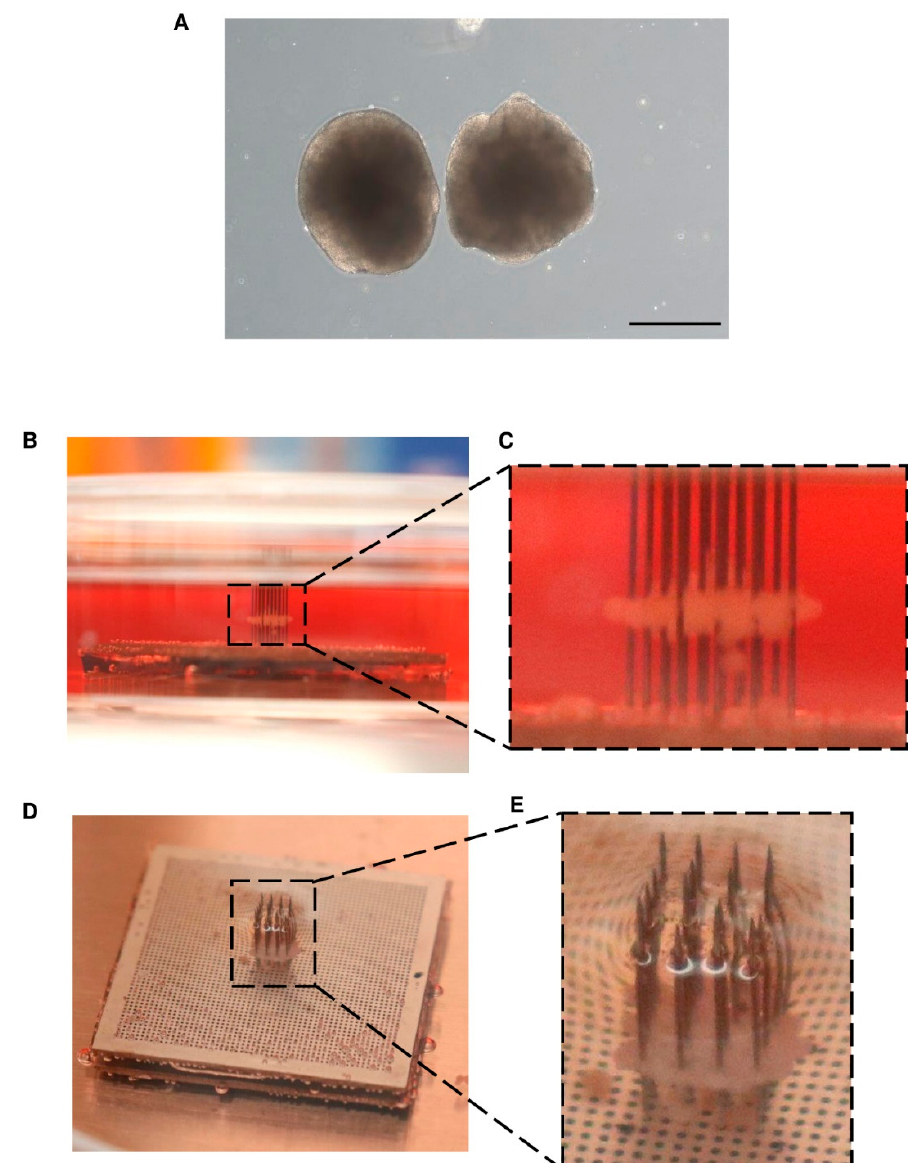
Figure 6. Proof-of-concept testing with human induced pluripotent stem cells (hiPSC) spheroids. hiPSC spheroids were cultured using a rotating culture flask method. ( A ) The spheroids were grown to an average diameter of 718 ± 77 μ m. Once enough spheroids were available to be used with the bioprinter to create a single layer, they were loaded into the bioprinter and placed onto the needles. ( B , C ) Side view of the hiPSC spheroid layer after placement onto the needles. ( D,E ) Top view of the hiPSC spheroid layer. The ability to print cellular spheroids onto the needle array confirms the efficiency of the layer-by-layer printing technique presented here.